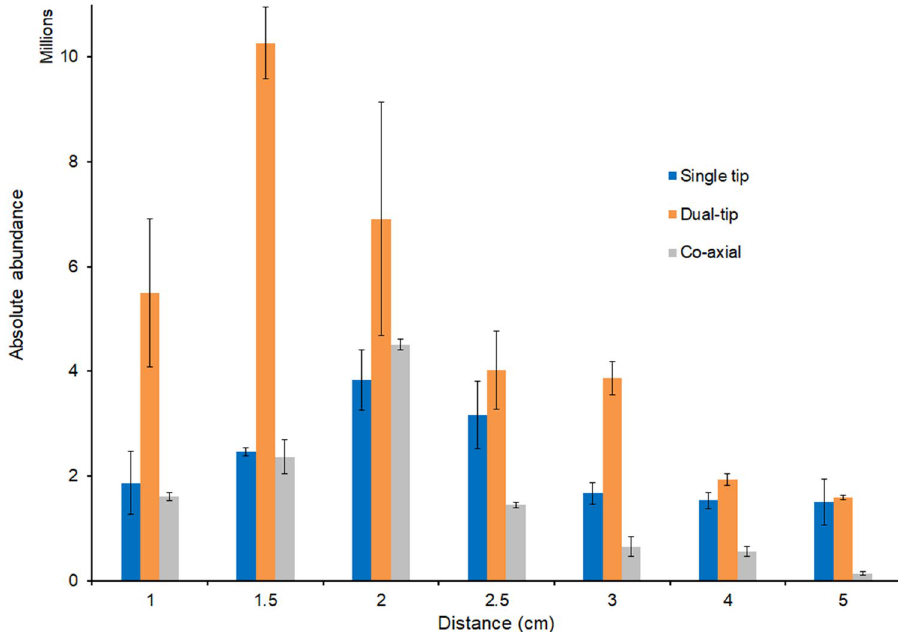
Figure 3. Absolute abundance of product ion ( m / z 327) from each paper arrangement loaded at different distances. The error bars indicate the standard deviation from three replicates.